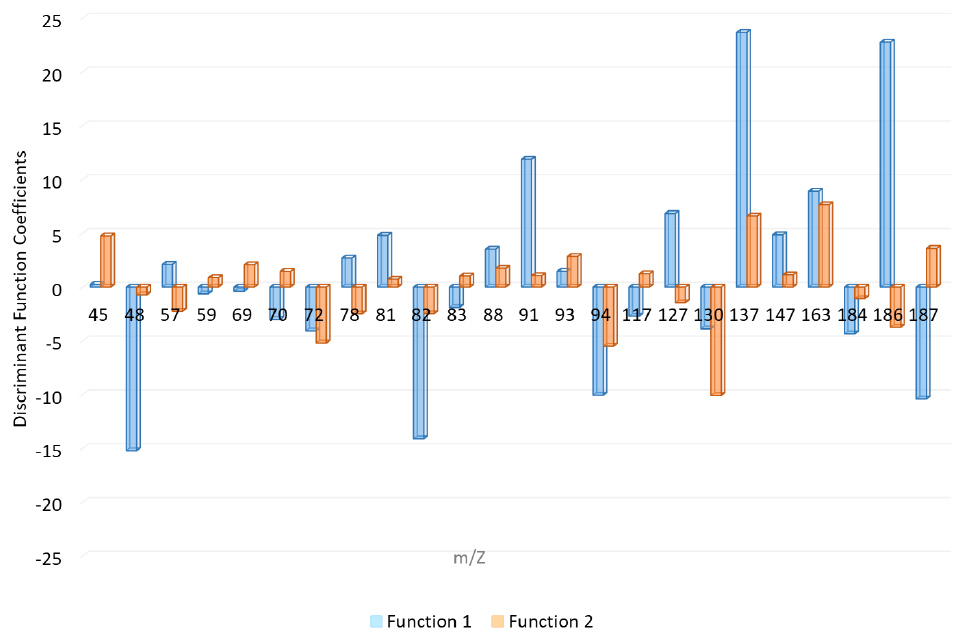
Figure 4. Standardized canonical discrimination coefficients.